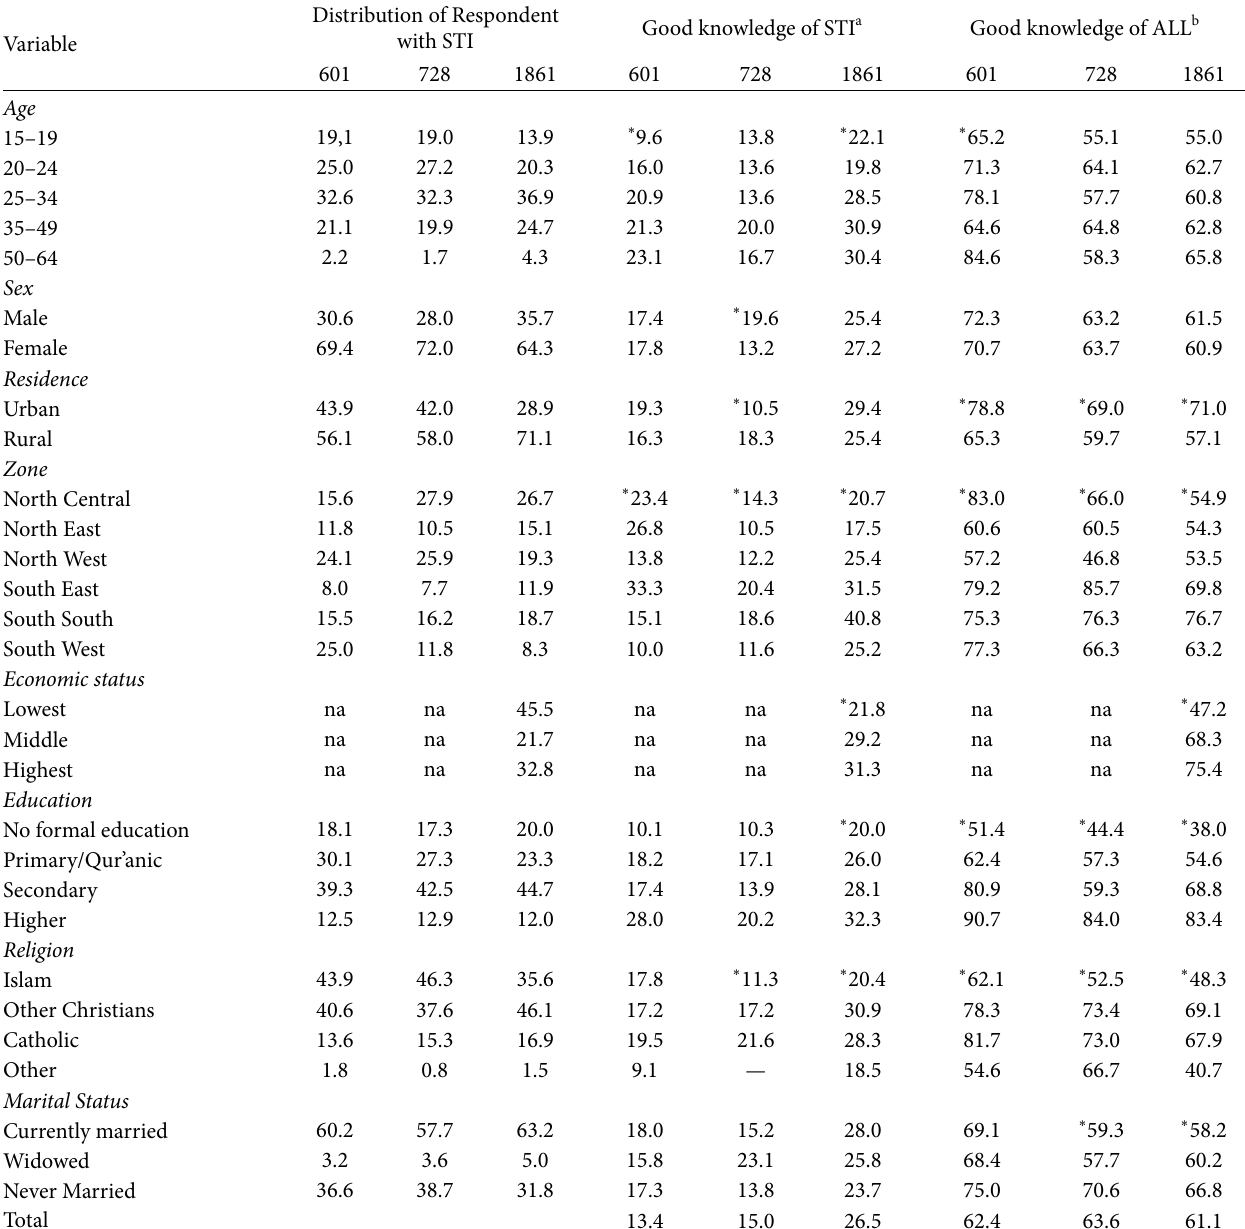
Table 4: Distribution of respondents with STI and bivariate association between respondents characteristics and knowledge of STI and HIV/